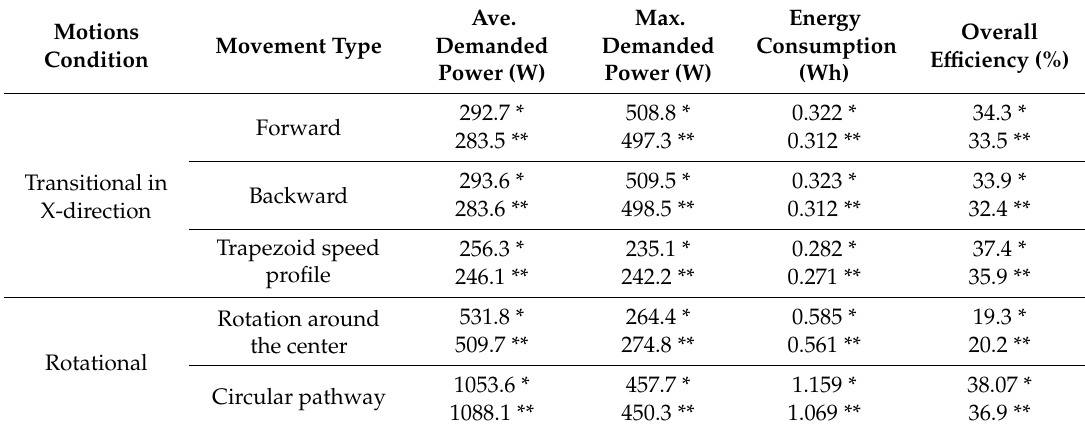
Table 4. Average value of the experimental and simulation results of the defined scenarios. Motions